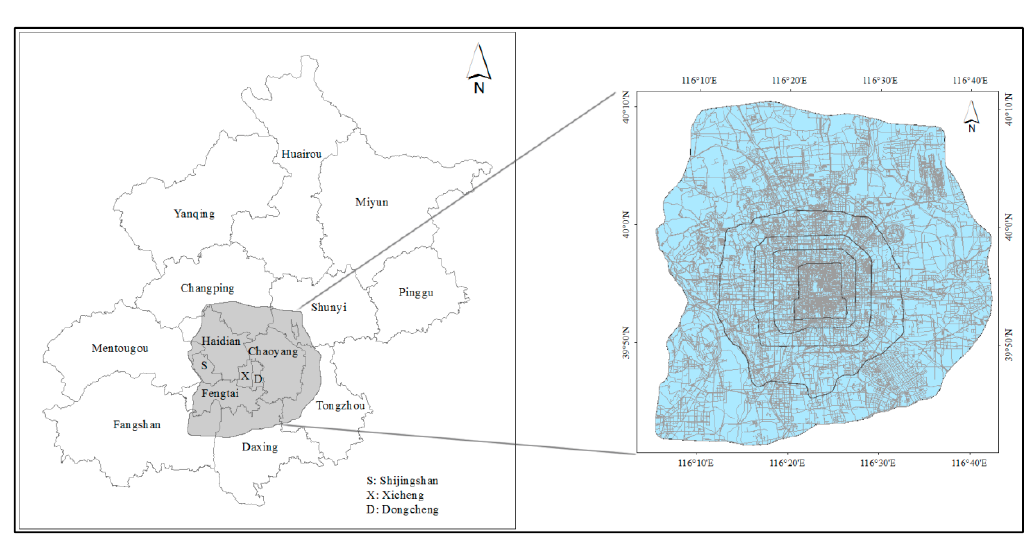
Figure 1. Study area in Beijing, denoted by blue. Table 1. Sample trip with pick ‐ up and drop ‐ off labels.